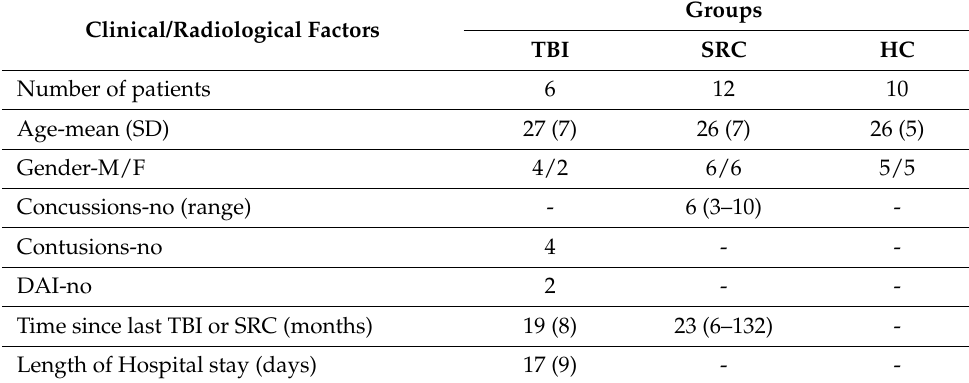
Table 1. Summary of the clinical and radiological data of the three